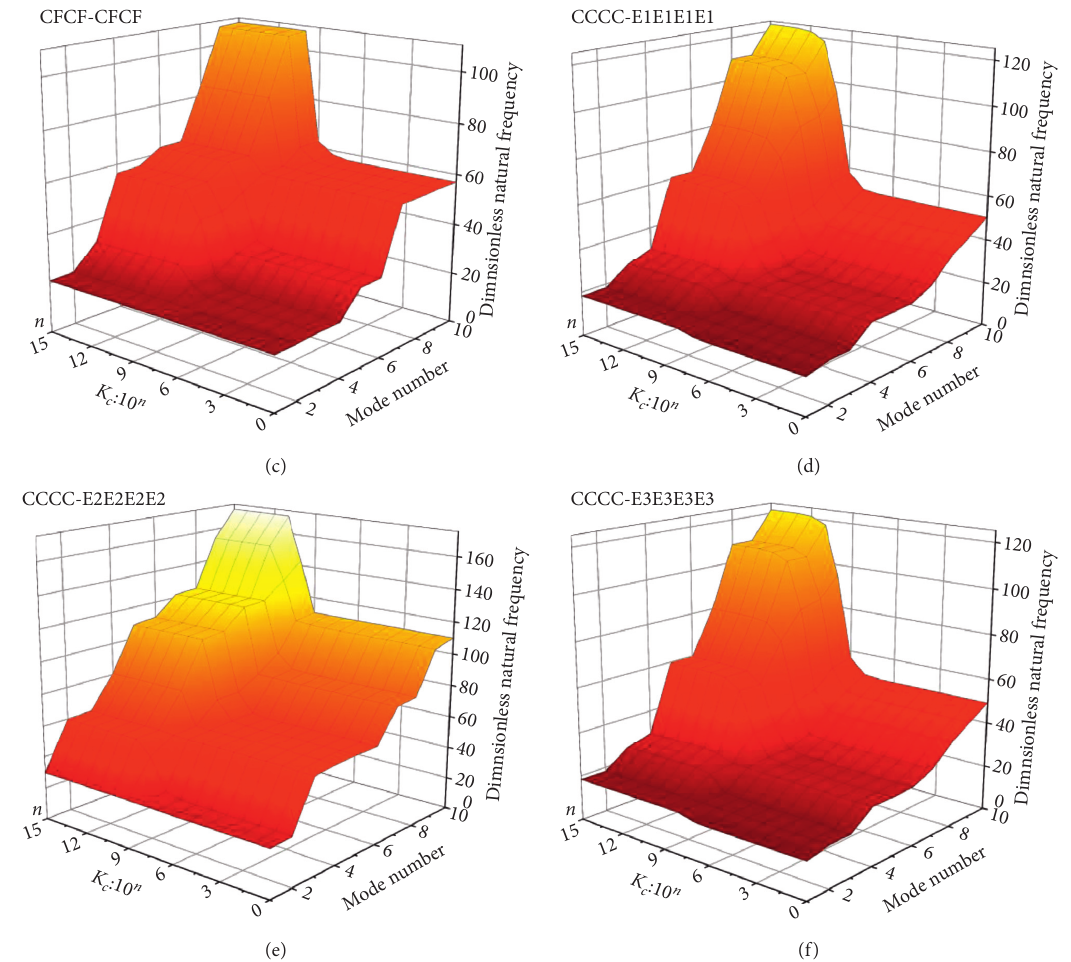
Figure 10: Variation of frequency parameter Ω versus middle spring stiffness for an LCDPS with different boundary conditions. (a) CCCC- CCCC; (b) CCCC-SSSS; (c) CFCF-CFCF; (d) CCCC-E 1 E 1 E 1 E 1 ; (e) CCCC-E 2 E 2 E 2 E 2 ; (f) CCCC-E 3 E 3 E 3 E 3